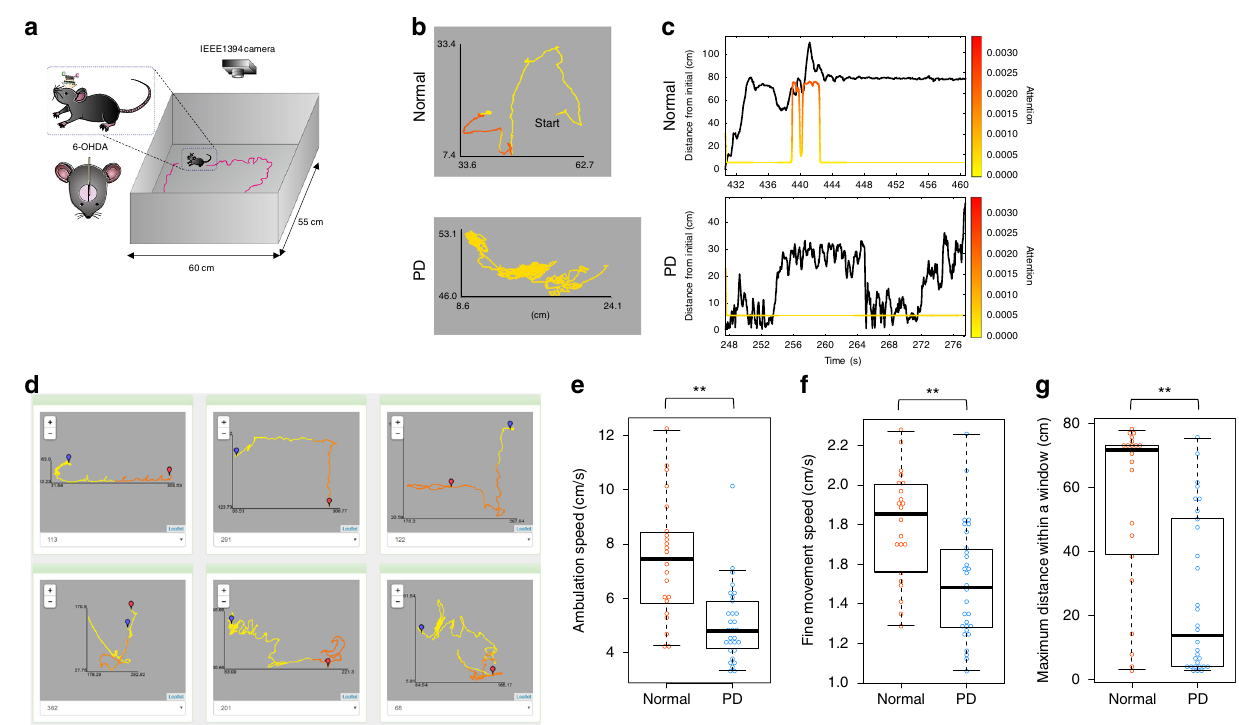
Fig. 4 DeepHL analysis of normal and PD mouse behavior. a Experimental apparatus and lesion protocol. b Example trajectories of mice colored by attention of the discriminator layer. The upper one is a trajectory of a normal mouse and the lower one is a trajectory of a 6-hydroxydopamine (OHDA) lesion mouse model of Parkinson ’ s disease (PD). The upper trajectory shows that when the mouse is far away from the initial position, the layer pays attention to the corresponding segments (red segments). c A time series of the straight-line distance from the initial position (black lines) associated with attention values (colored lines). d A screenshot of DeepHL for comparing multiple trajectories colored by the discriminator layer at a glance (normal mice). A blue balloon shows the initial position of each trajectory. e – g Average movement speed during ambulation periods, average movement speed during fi ne movement periods, and average maximum distance within a ±60-s window in a session of normal and PD mice for each entire trajectory (see “ Methods ” ). Signi fi cant differences between normal and PD mice were observed for all three features (Wilcoxon rank-sum test, p = 3.486 × 10 − 5 , p = 5.869 × 10 − 4 , p = 2.666 × 10 − 4 ; ** p < 0.01; n = 22 original 10-min trajectories from normal; n = 30 original 10-min trajectories from PD). The p values are two sided. The edges of the box plot correspond to 95% con fi dence intervals, the embedded bar represents the median, and whiskers show minimum and maximum values. Dots show values for individual